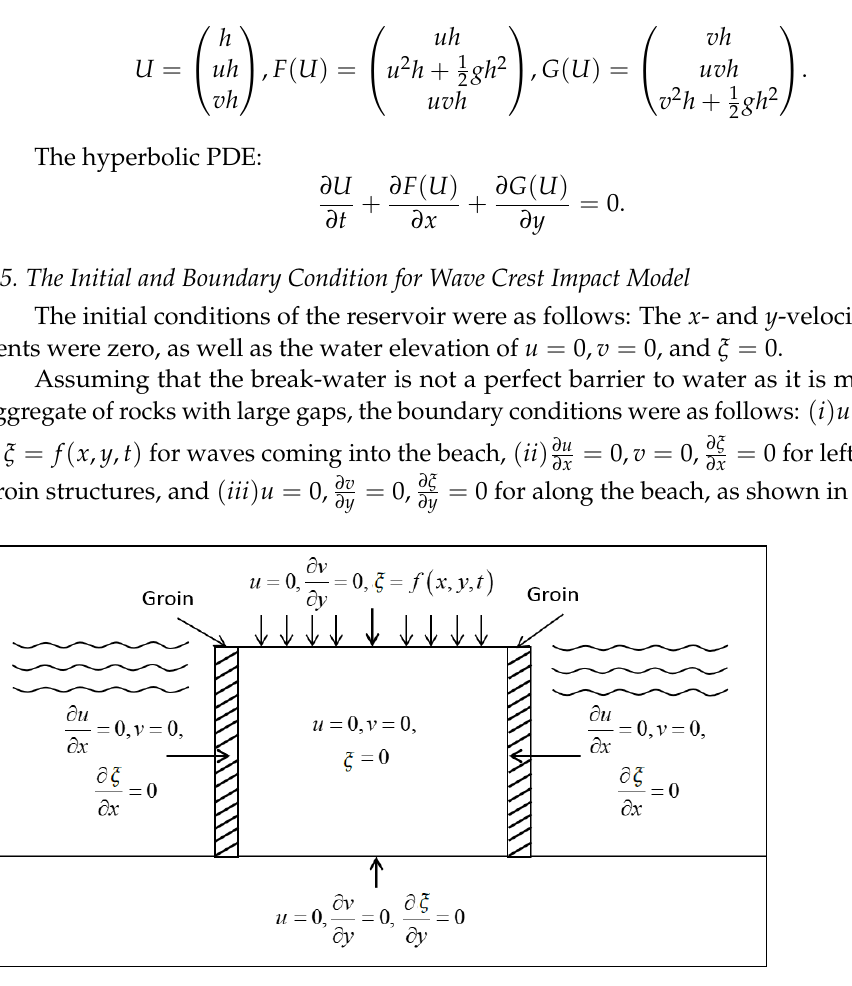
Figure 4. Initial and boundary